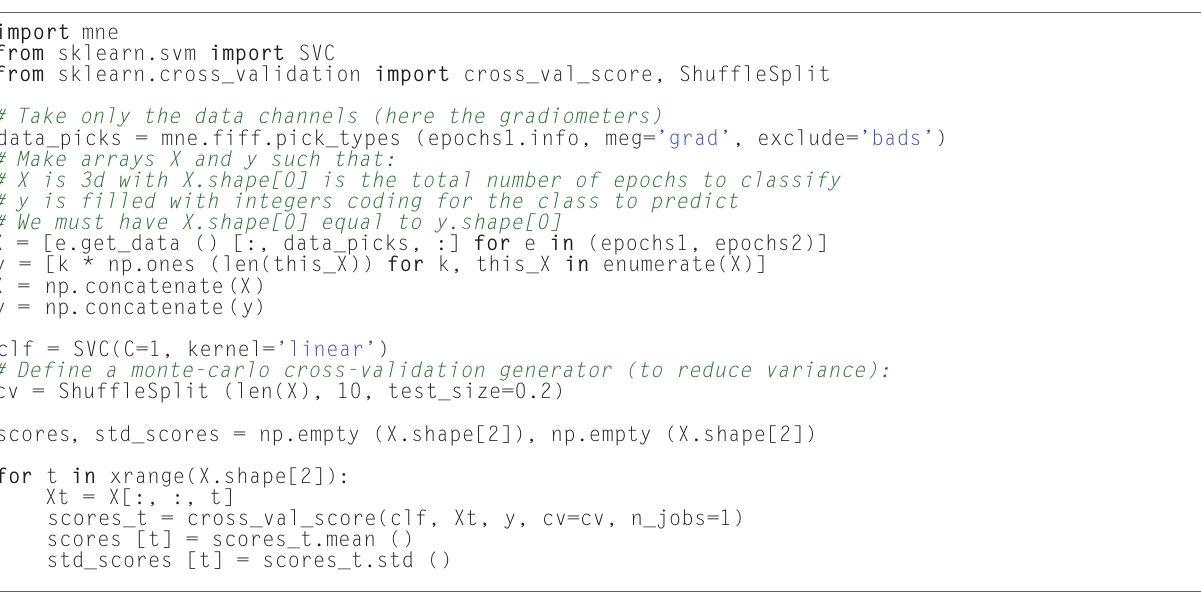
Table 3 | Sensor space decoding of MEG data.